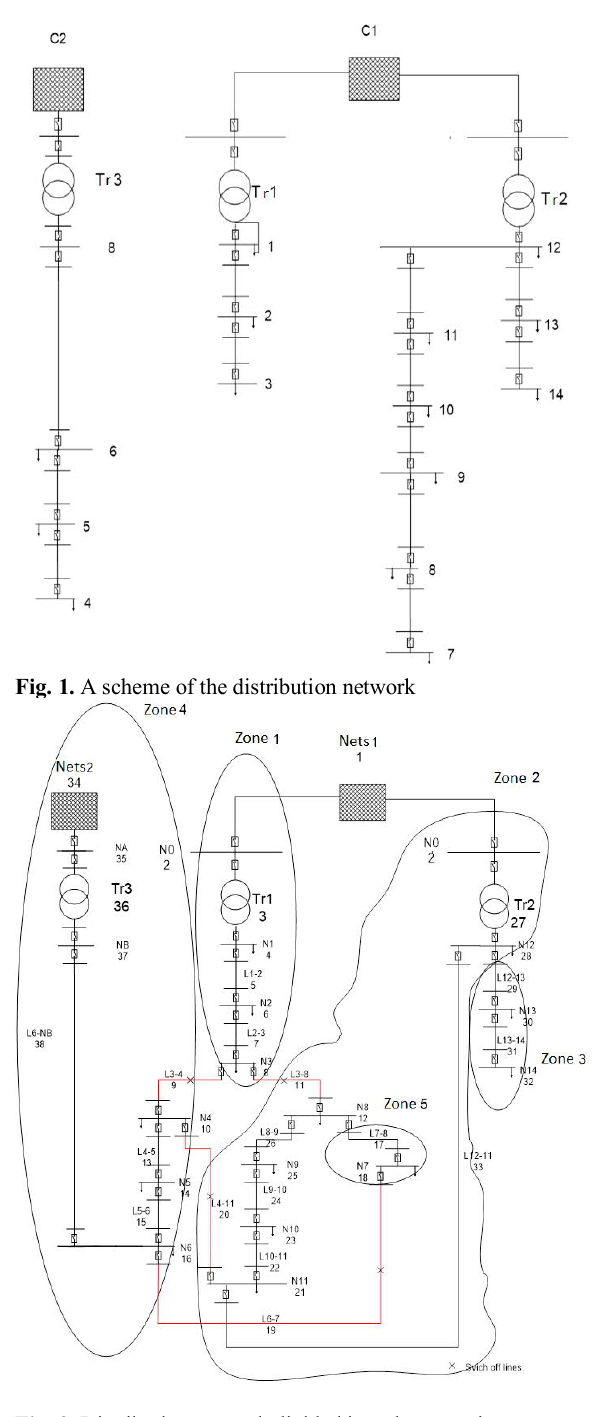
Fig. 2. Distribution network divided into the operating